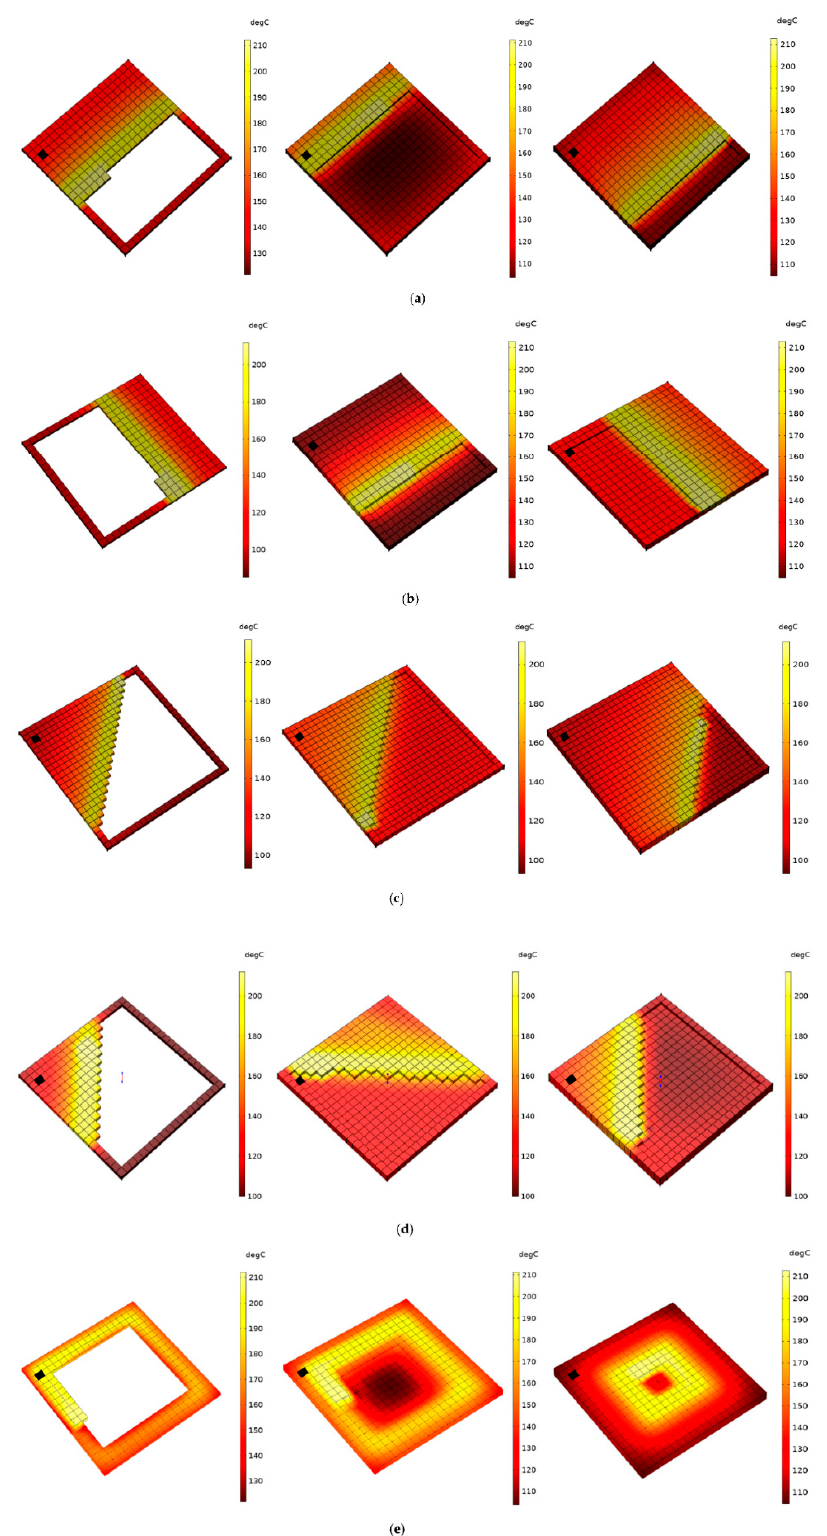
Figure 6. Representation of sequential element activation of various raster patterns considered in this study with respect to their material deposition. ( a ) sample a-Rs (90 ◦ /90 ◦ ), ( b ) Sample b-L (0 ◦ /90 ◦ ), ( c ) sample c-Z (45 ◦ /45 ◦ ), ( d ) sample d-Z (45 ◦ / − 45 ◦ ) and ( e ) sample e-Con. A black marker is placed in all the samples to illustrate the location of element m in order to understand the reheating effect imposed on it by the adjacent road